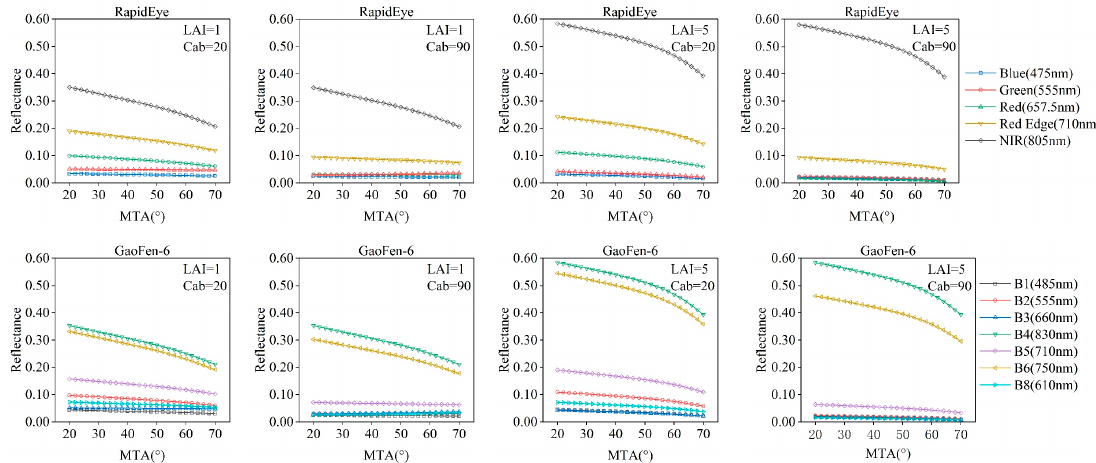
Figure 3. Responses of satellite broadband reflectance to leaf mean tilt angle (MTA) from PROSAIL model simulation for four combinations of high and low LAI and Cab: low LAI and low Cab ( left column ), low LAI and high Cab ( second column ), high LAI and low Cab ( third column ) and high LAI and high Cab ( right column ) for Sentinel ‐ 2 ( top row ), WorldView ‐ 2 ( second row ), RapidEye ( third row ), and GeoFen ‐ 6 ( bottom row ).